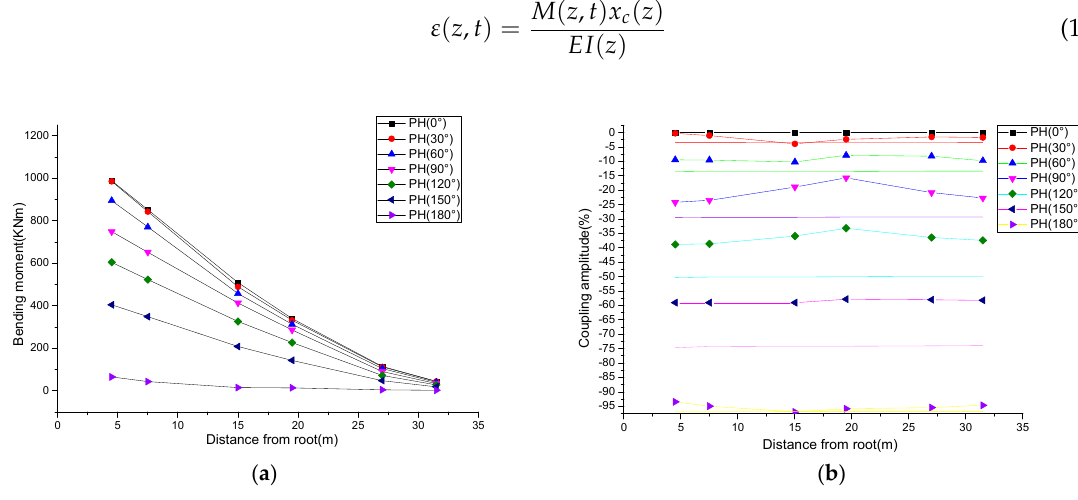
Figure 10. Phase difference and bending moment distribution. ( a ) Bending moment distribution with phase difference; ( b ) Bending moment decrease with phase difference, compared with FEM results.